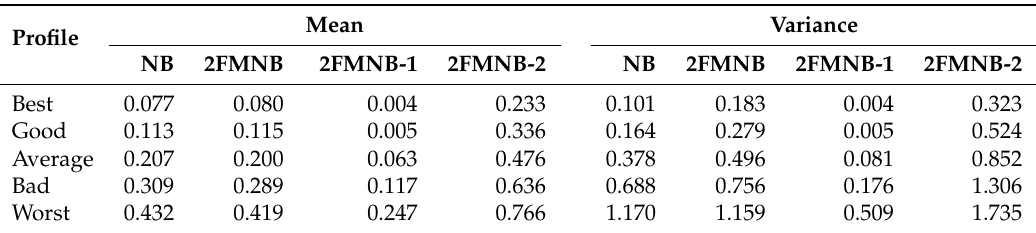
Table 5. The mean and the variance derived from the simple negative binomial model (NB) and the